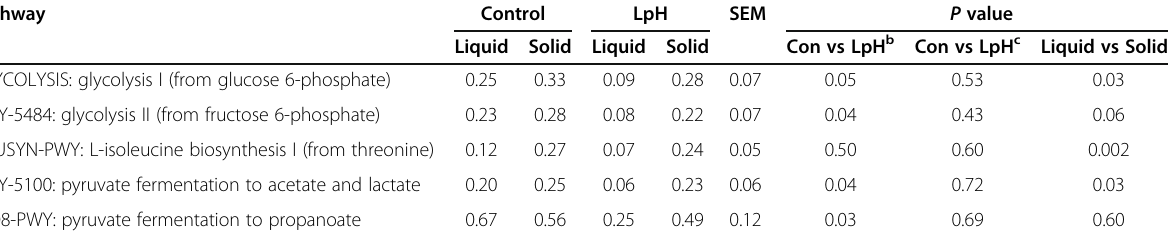
Table 1 Functional pathways that were significantly different among treatments a